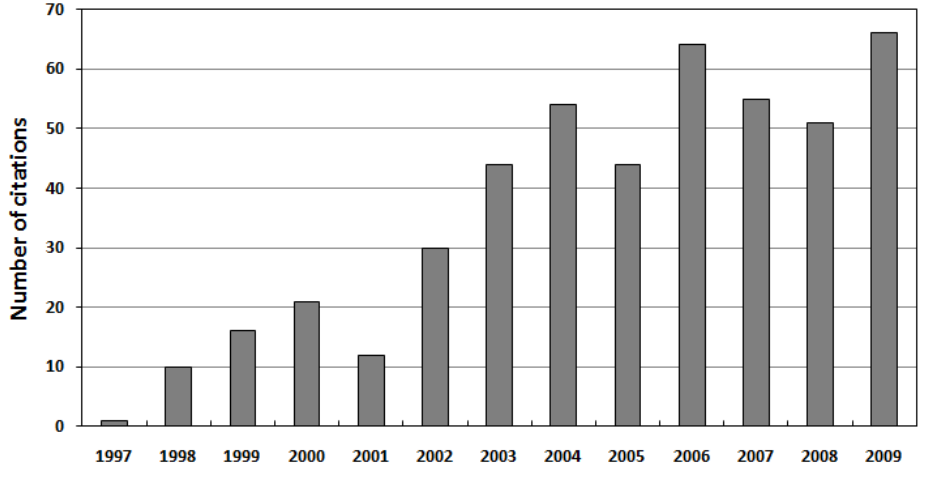
Figure 2. Number of citations of the 1996 paper by Matsuzawa et al . [5] according to the Web of